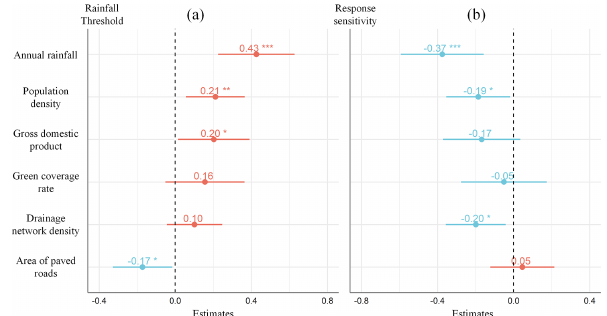
Figure 8. Regression coefficients between the six explanatory vari- ables and the 6h rainfall threshold (a) and response sensitivity (b) . The horizontal lines mean the 95% confidence